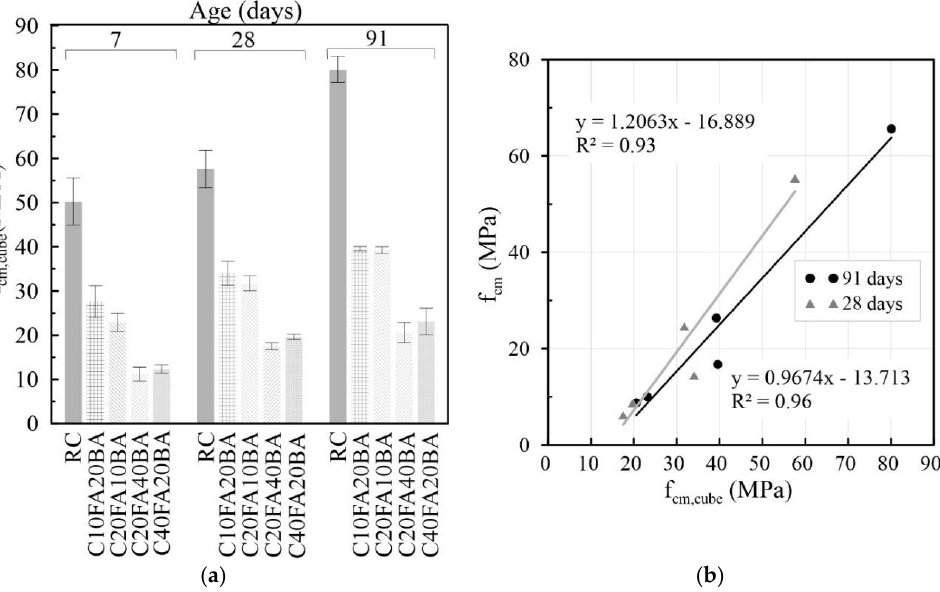
Figure 4. Compressive strength in cubes (f cm,cube ) at 7, 28 and 91 days ( a ); relationship between compressive strength in cubic (f cm,cube ) and cylindrical specimens (f cm ) at 28 and 91 days ( b ).